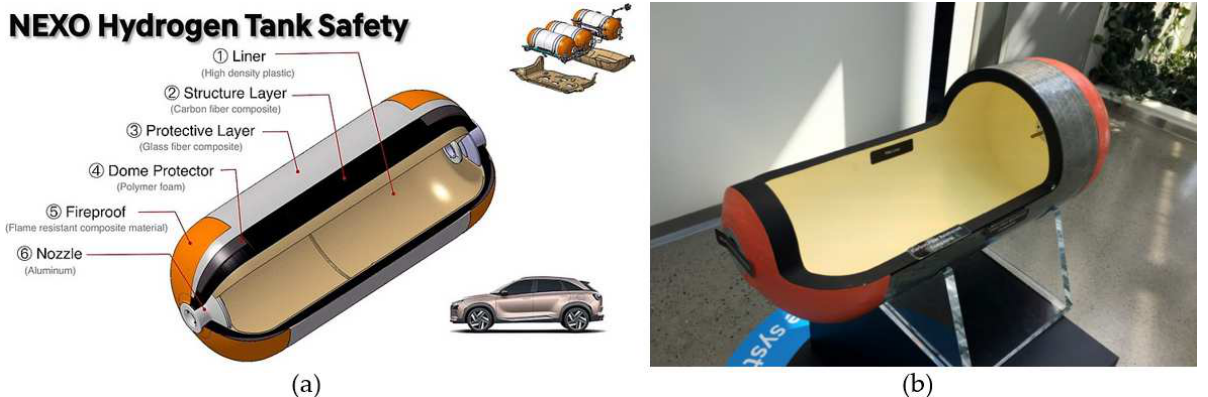
Figure 1. ( a ) Schematic cross-section of a hydrogen tank for Hyundai Nexo [18]; ( b ) photograph of a sectioned Hyundai Nexo hydrogen tank [19].